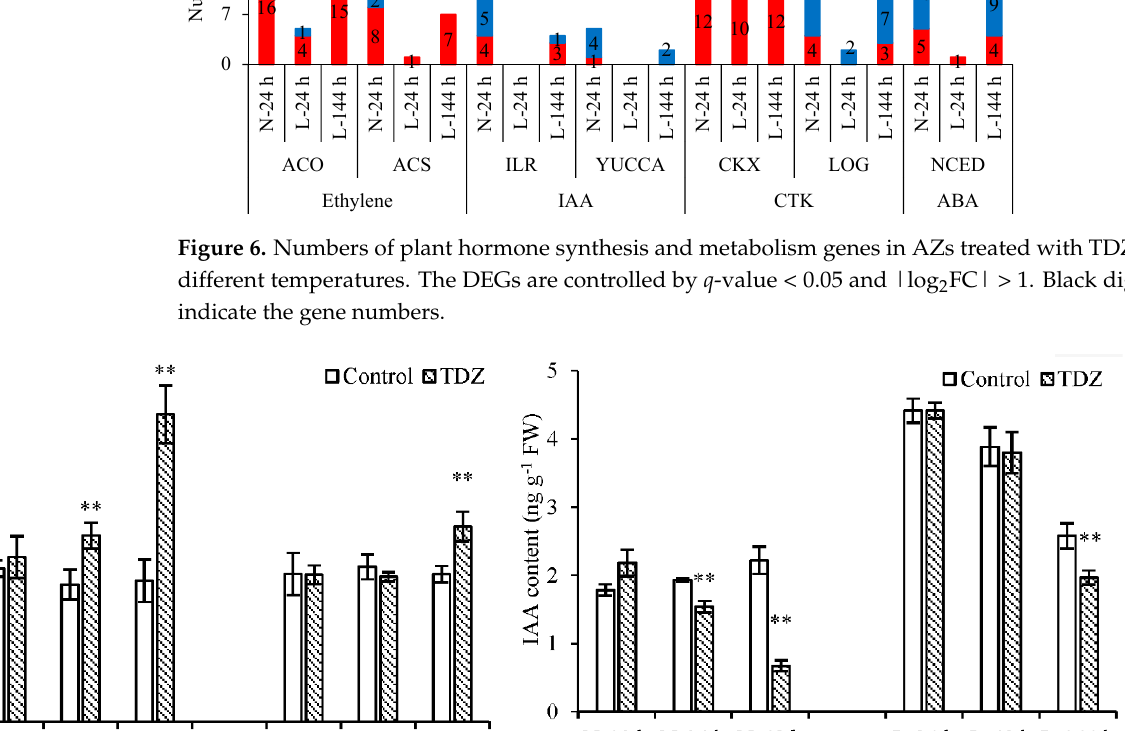
Figure 8. The expression of cell wall hydrolase genes in AZs treated with TDZ at different temper- atures. ( A ) Numbers of upregulated cell wall hydrolase genes in AZs treated with TDZ; ( B ) the expression levels of selected cell wall hydrolase genes from RT-qPCR. 0510 15